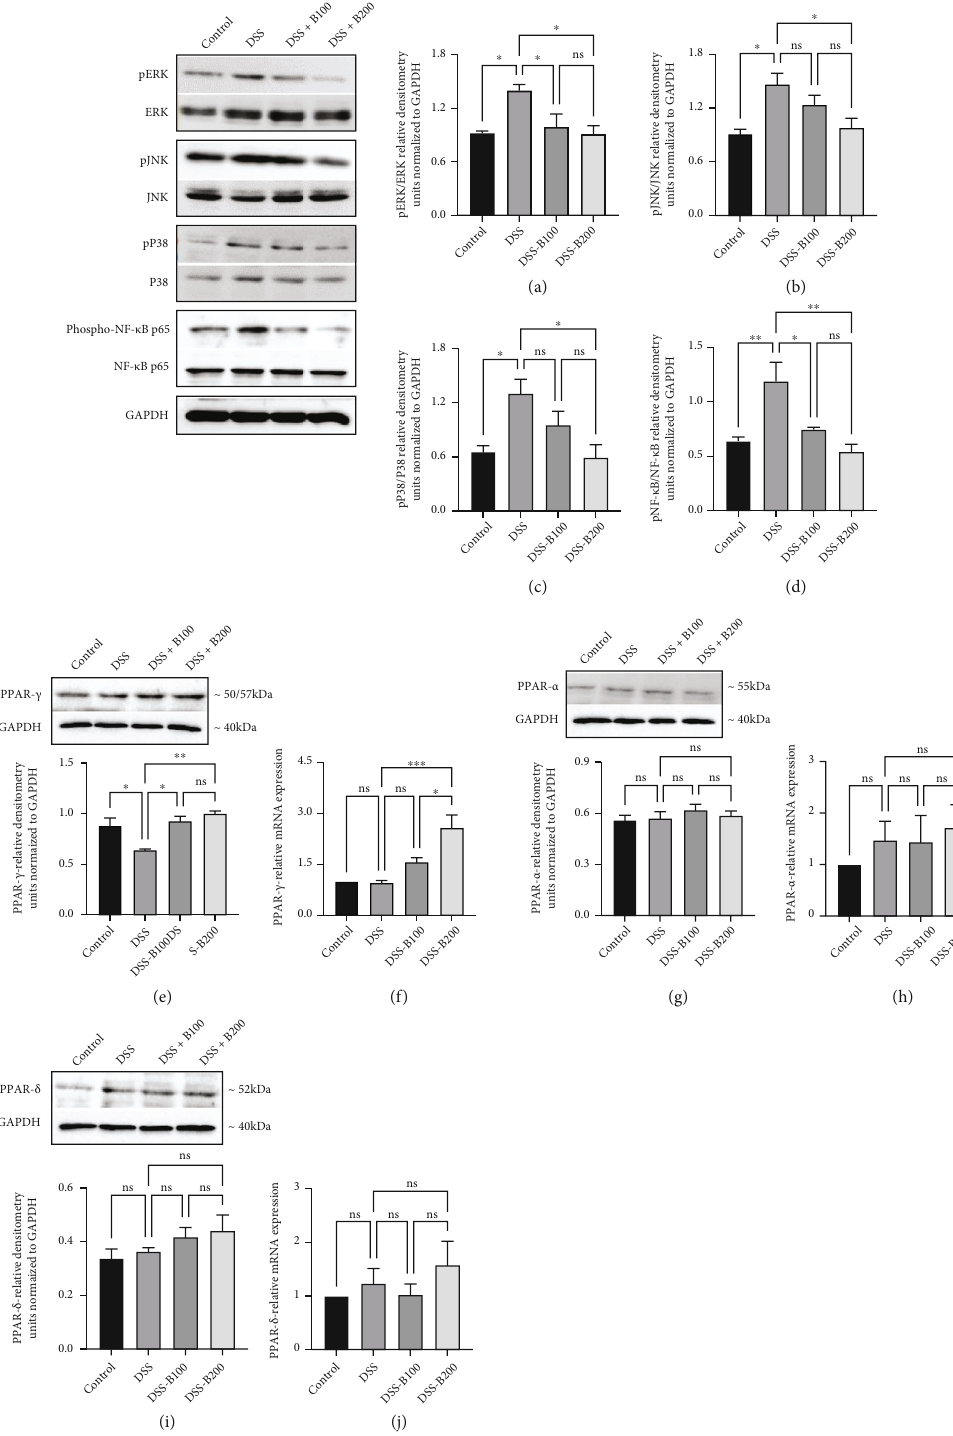
Figure 5: E ff ect of bisabolol on colon MAPK, NF- κ B signaling, PPAR- γ , PPAR- α , PPAR- β , protein, and mRNA expression. DSS administration signi fi cantly increased phosphorylation of ERK (a), JNK (b), p38 (c), and pNF- κ Bp65 (d) proteins. Bisabolol treatment signi fi cantly prevented the increase in the phosphorylation of these proteins. DSS administration signi fi cantly reduced expression of PPAR- γ at both the protein and mRNA levels. Bisabolol treatment signi fi cantly increased the PPAR- γ expression at both the protein and mRNA levels (e, f). PPAR- α (g, h) and PPAR- β (i, j) were not a ff ected by DSS or bisabolol treatment at either the protein and mRNA levels. The density of immunoblots was normalized to GAPDH. Five ( n = 5 ) animals used for Western blot and mRNA measurements. The data expressed as mean ± SEM . ∗ p < 0 : 05 , ∗∗ p < 0 : 01 , and ∗∗∗ p < 0 : 001 .ns: not signi fi